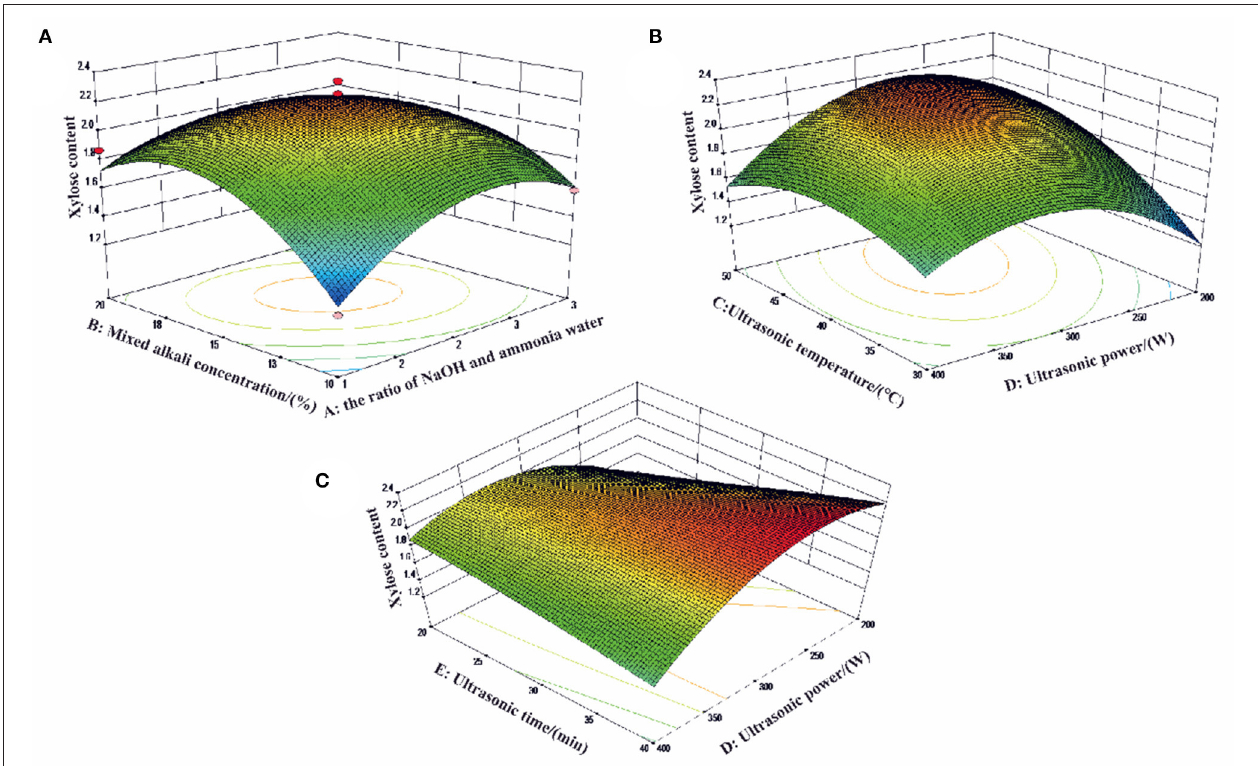
FIGURE 3 | The effects of (A) the ratio of NaOH and ammonia water; (B) mixed alkali concentration (%); (C) ultrasonic temperature ( ◦ C); (D) ultrasonic power (W) and (E) ultrasonic time (min) on xylose content of three-dimensional (3D) response surface